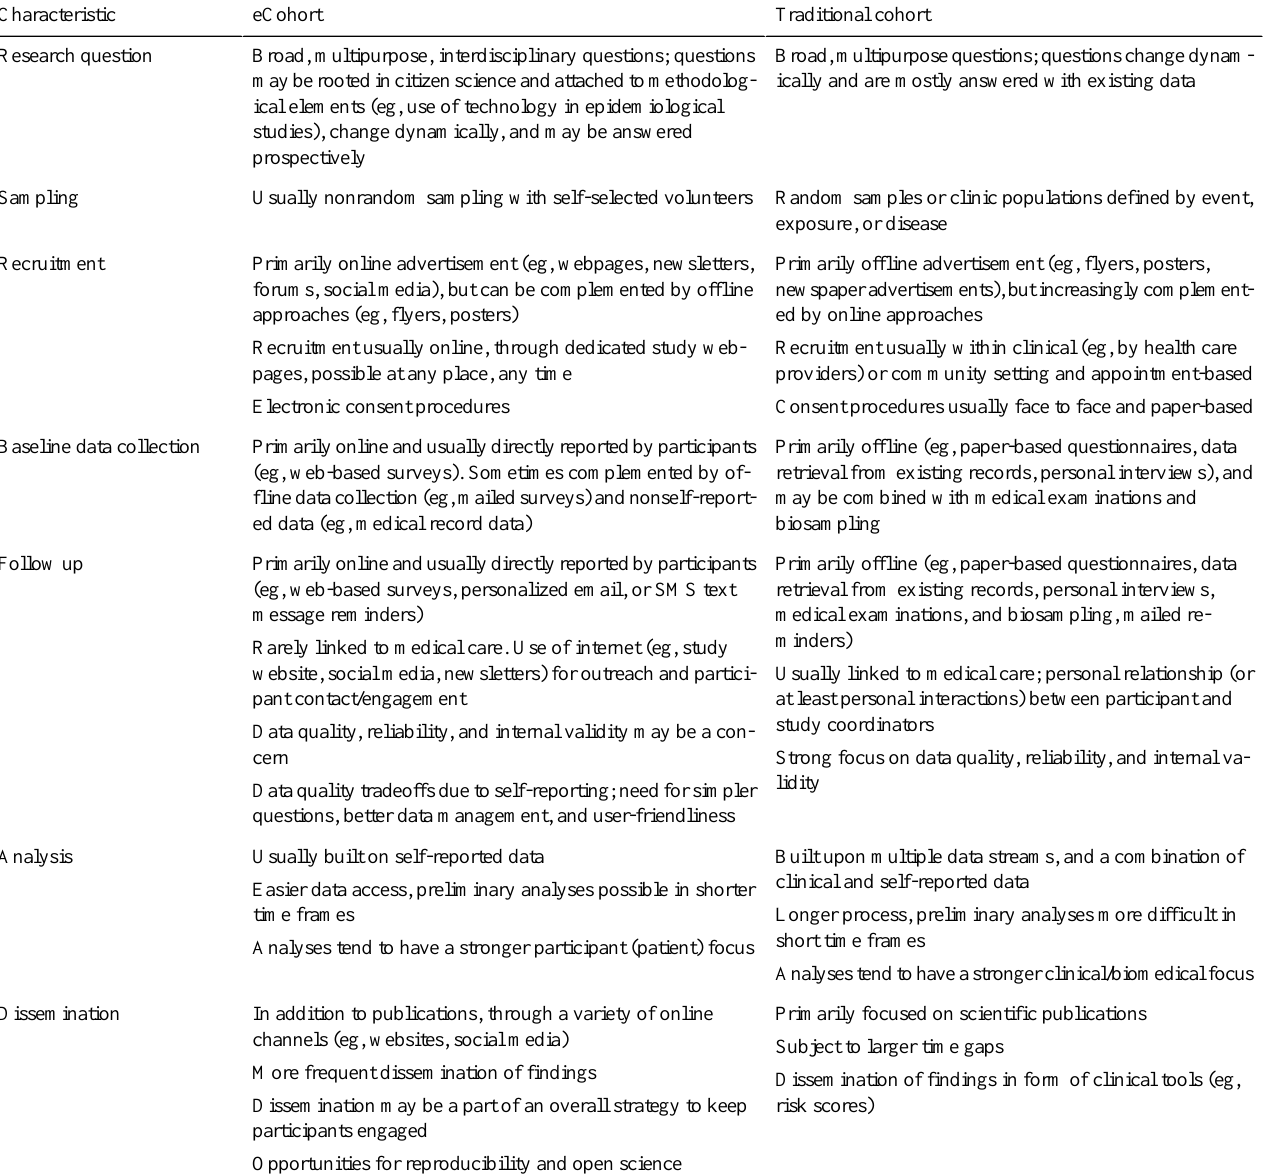
Table 2. Comparison of eCohorts to traditional cohorts. dataBroad, multipurpose, interdisciplinary questions; questions may be rooted in citizen science and attached to